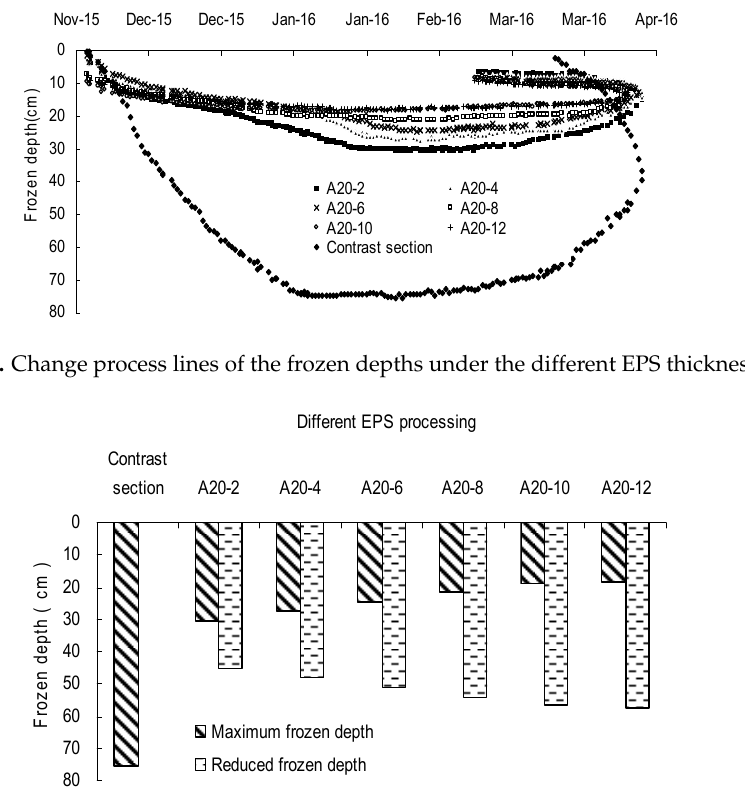
Figure 7. Maximum frozen depth and reduced frozen depths under the different EPS thicknesses.